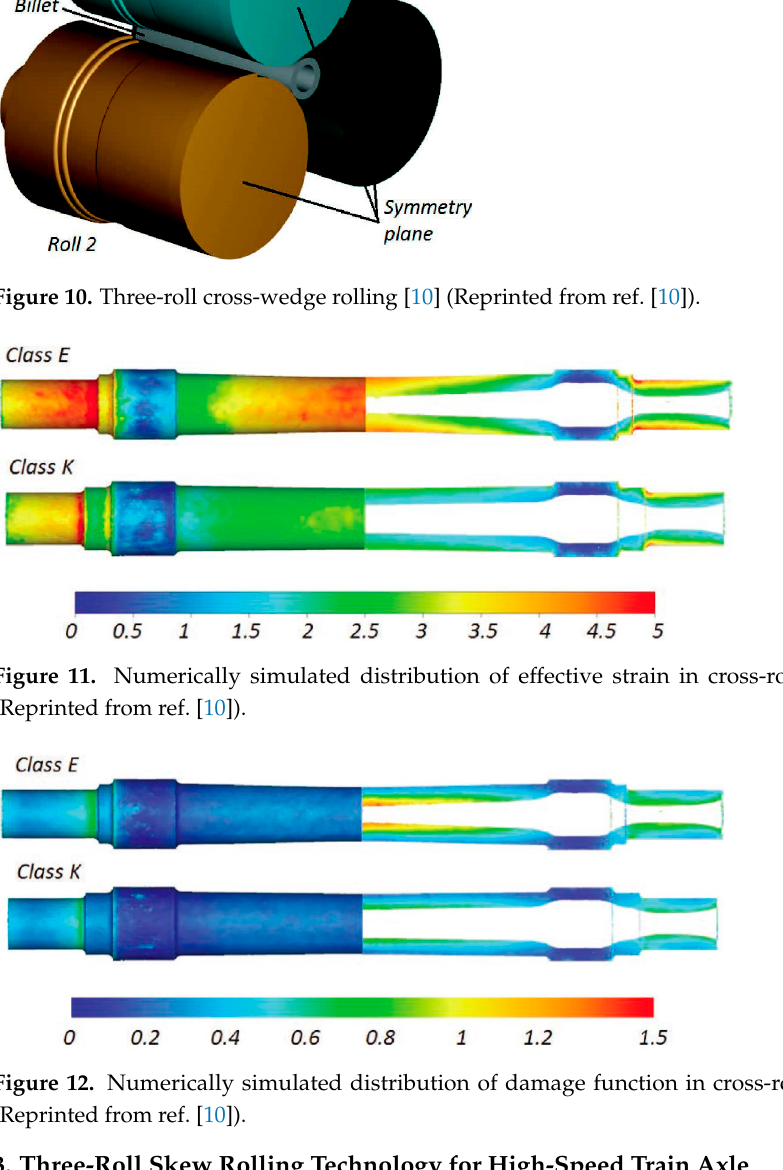
Figure 13. Design of the skew rolling process with three tapered rolls [12] (Reprinted from ref. [12]). Zhang and Pater made many contributions to the velocity vector analysis of the de- formation zone of the rolled piece during stable rolling, as shown in Figure 14 [13,14]. Point O is defined as the rotation center of the roller around the rotation when the feed angle is adjusted, and the vertical line of the rolling line (the rolling line is generally coin- cident with the axis of the rolled piece) is the rotation axis. The plane composed of the rotating axis and rolling line is the main rolling plane, and the plane composed of the rotating axis and roller axis is the main roller plane. Taking any point P in the deformation zone as the coordinate origin, the crossing point P is the x-axis along the rolling direction, the crossing point P is the y-axis along the tangential direction of the rolled piece, and the vertical line of the crossing point P as the rolling line is the z-axis. The A-A view is the projection along the rolling direction perpendicular to the main plane of the rolling, and the B-B view is the projection along the roll axis perpendicular to the main rolling plane. β is the feed angle, γ is the angle between the z-axis and the main rolling plane, and j is